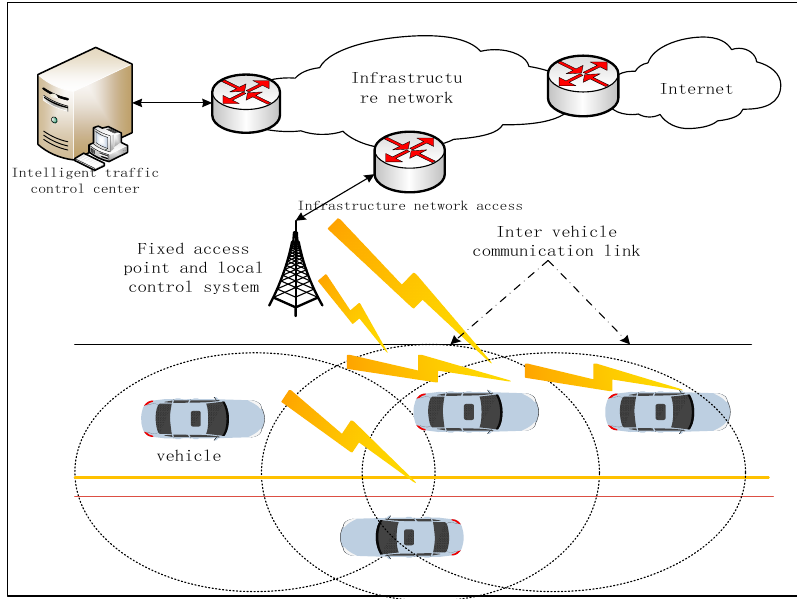
Figure 2. Vehicular networking architecture diagram.